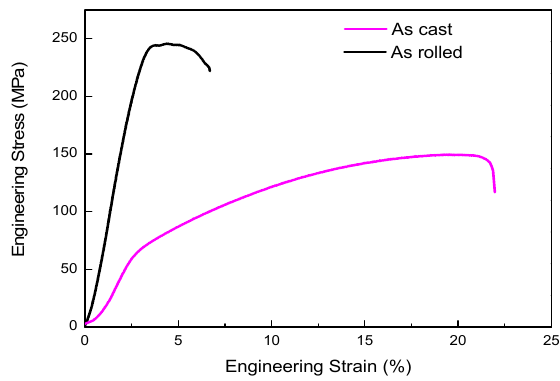
Figure 5. Mg-2Y-0.6Nd-0.6Zr alloy stress and strain curves of the as-cast and as-rolled states.